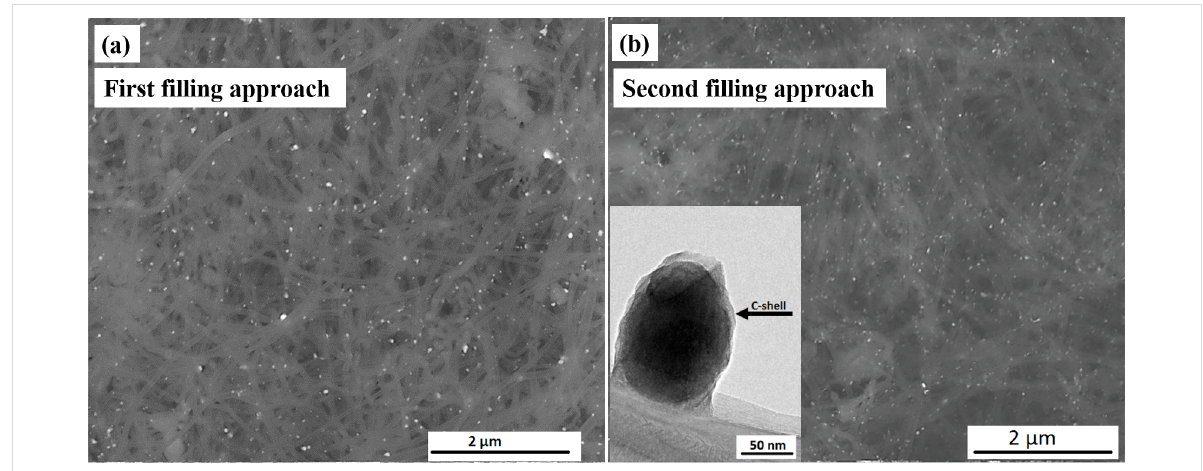
Figure 2: SEM overview images in BSE contrast of the annealed samples of Fe 50 Co 50 @CNT (at 600 °C for 48 h) prepared by the a) first (solution) and b) second filling approach. Inset: a MNP, attached to the outer surface of a CNT, and covered with a carbon